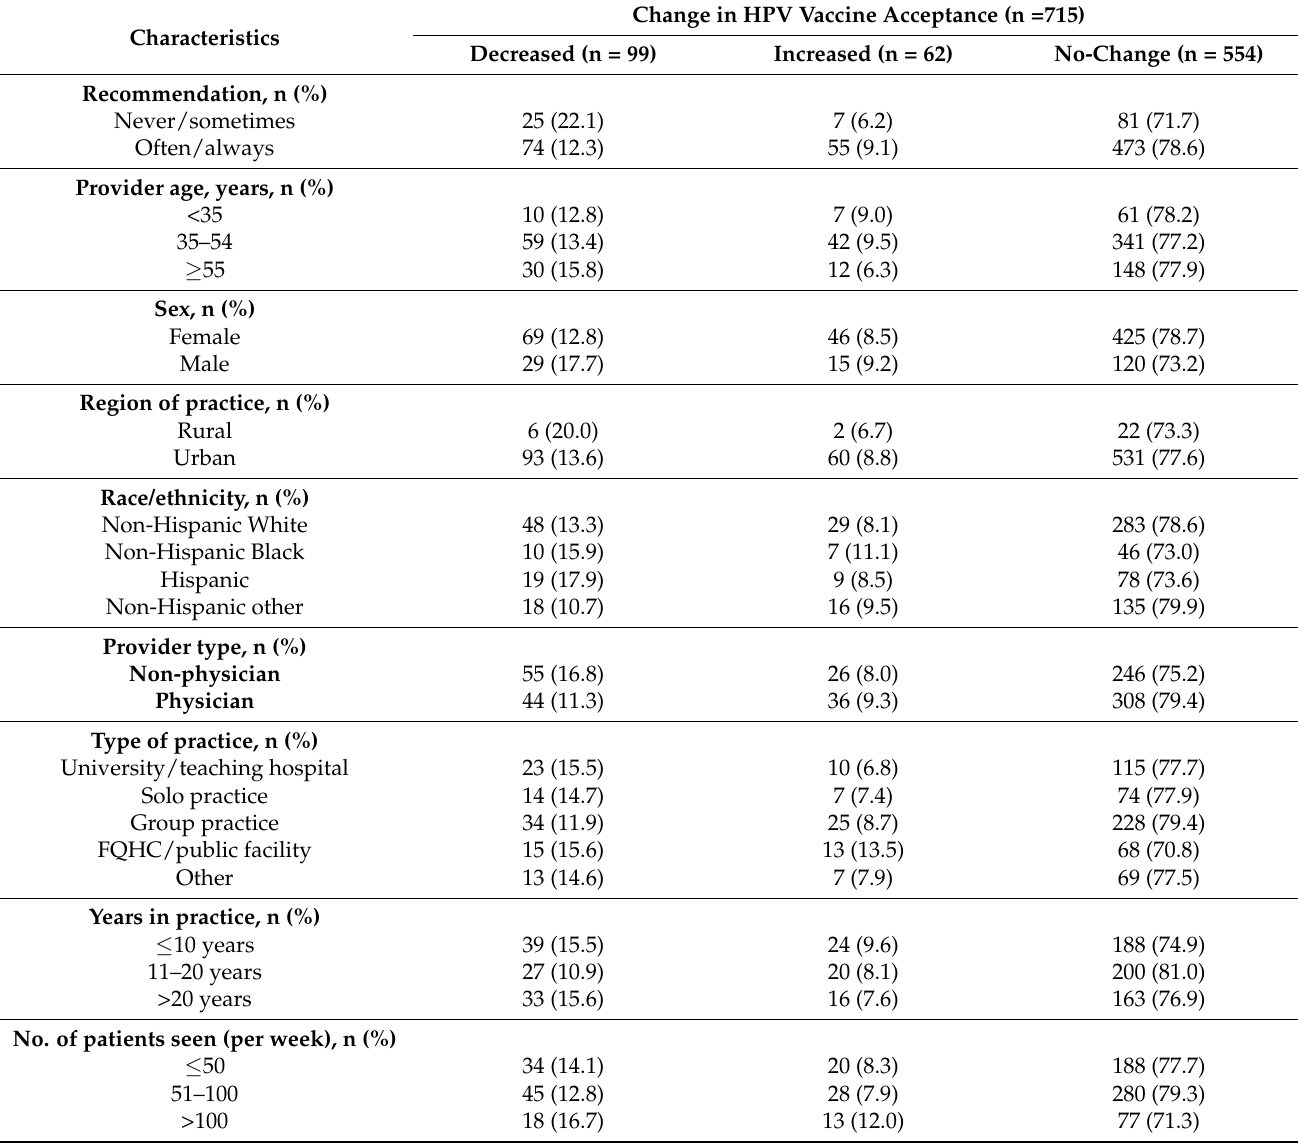
Table 1. Distribution of recommendation and provider-related characteristics by observed changes in HPV vaccination acceptance during the COVID-19